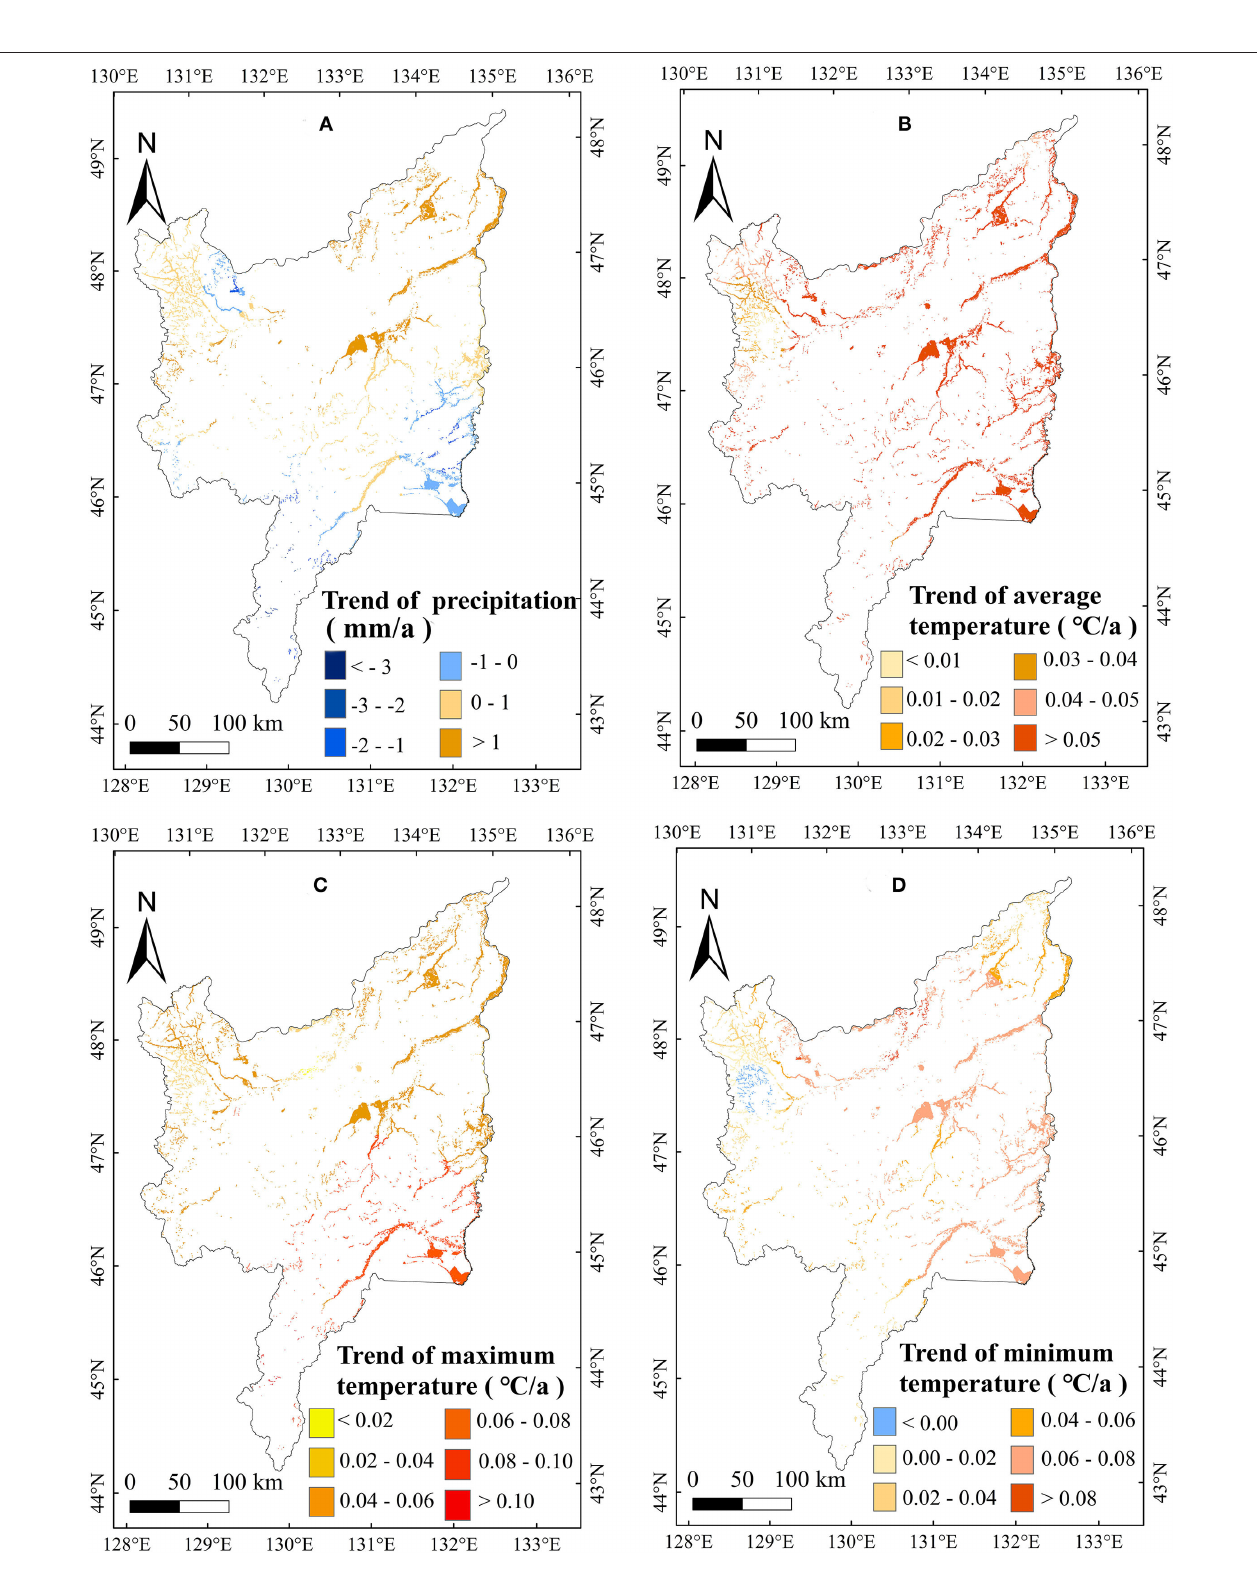
FIGURE 11 | Change trends in precipitation (mm/a) (A) , T mean ( ◦ C/a) (B) , T max ( ◦ C/a) (C) , and T min ( ◦ C/a) (D) in July in marshes of the Sanjiang Plain from 2000 to 2020.